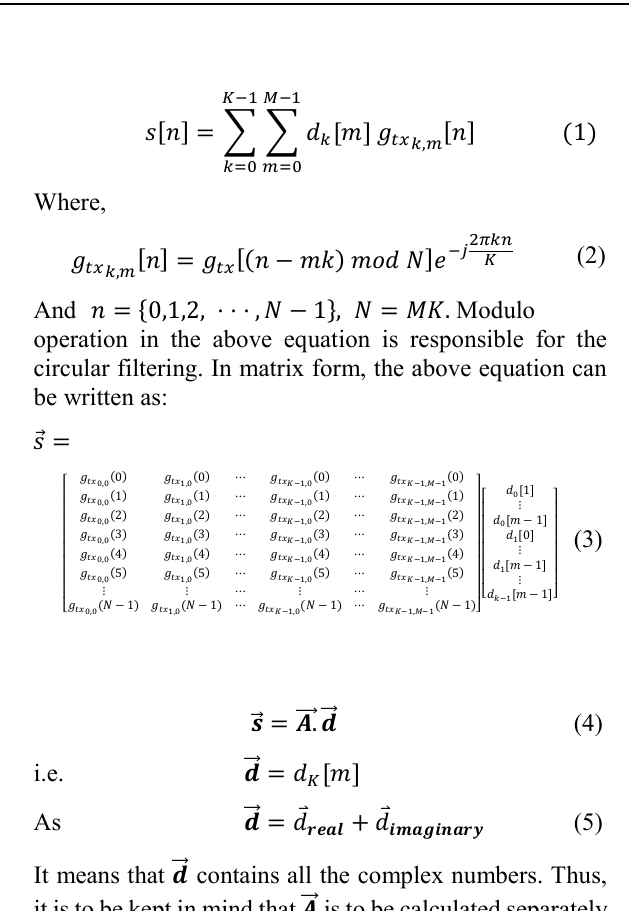
Real part of the data Imaginary part of the data Imaginary part of 𝒔⃗